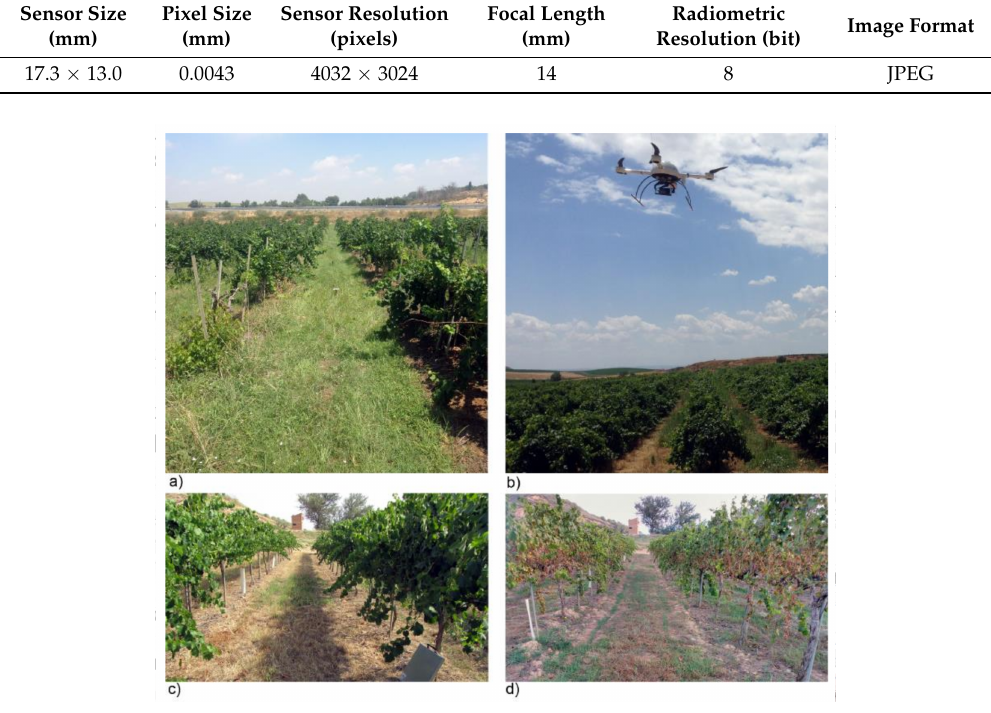
Figure 1. Images of the studied fields at different growth stages: ( a ) inter-row cover crop growing in Field C in July; ( b ) the UAV flying over Field B; and ( c , d ) comparison between the field situations (green cover crops, vines, and bare soil) between July and September in Field